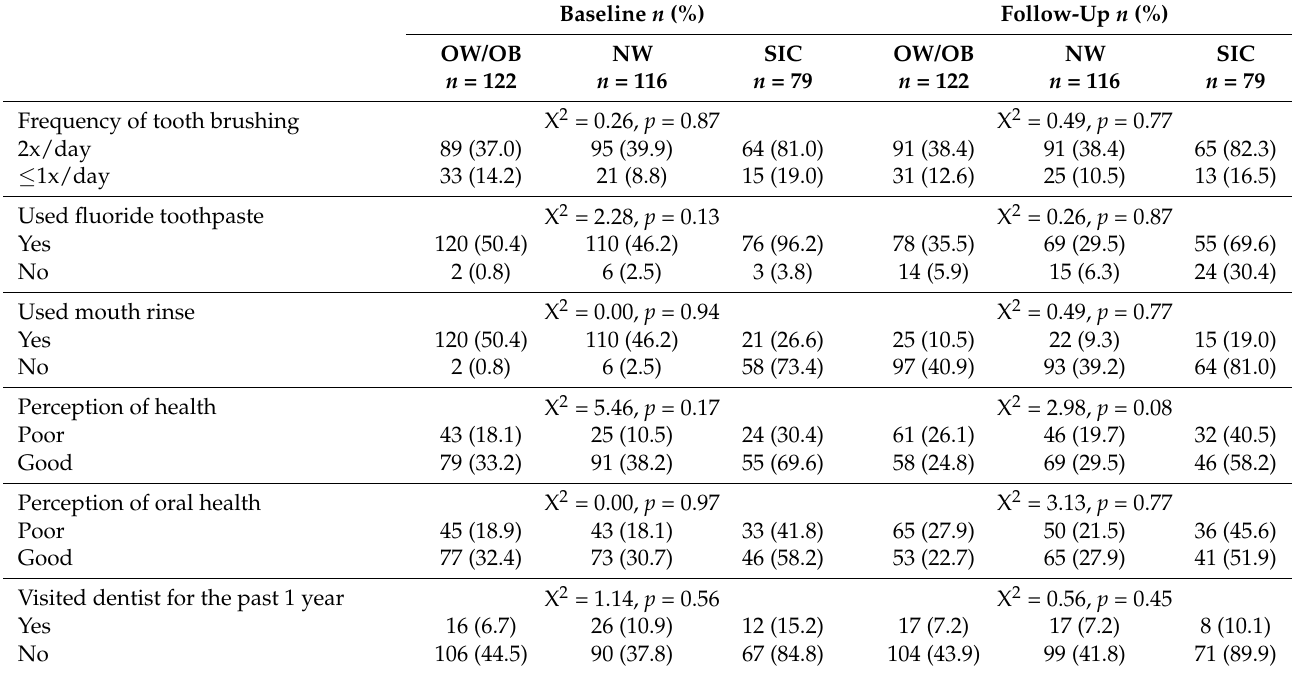
Table 2. Oral hygiene practice and perception on health and oral health in obese, normal weight, and SiC groups at baseline and